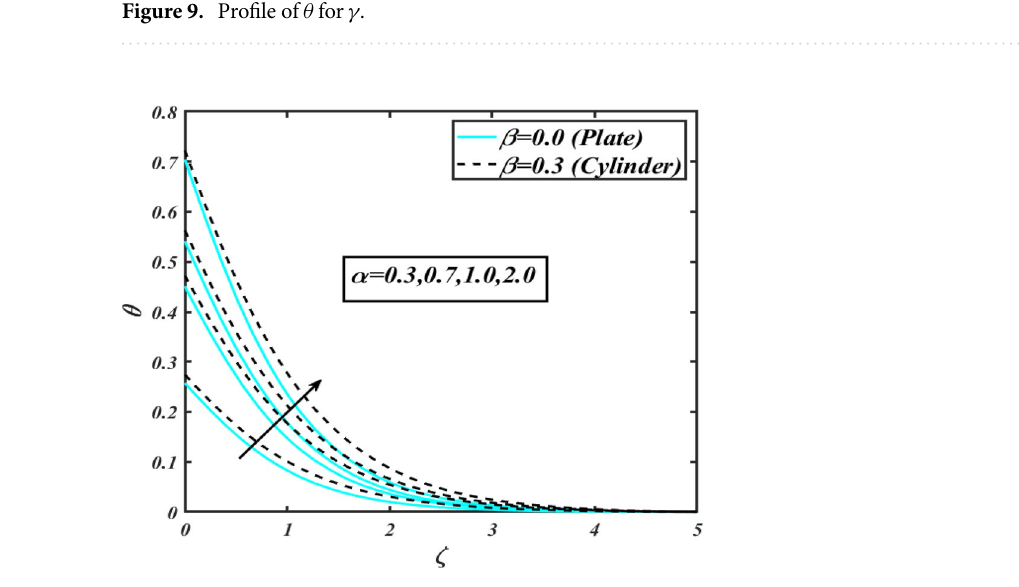
Figure 10. Profile of θ for α .